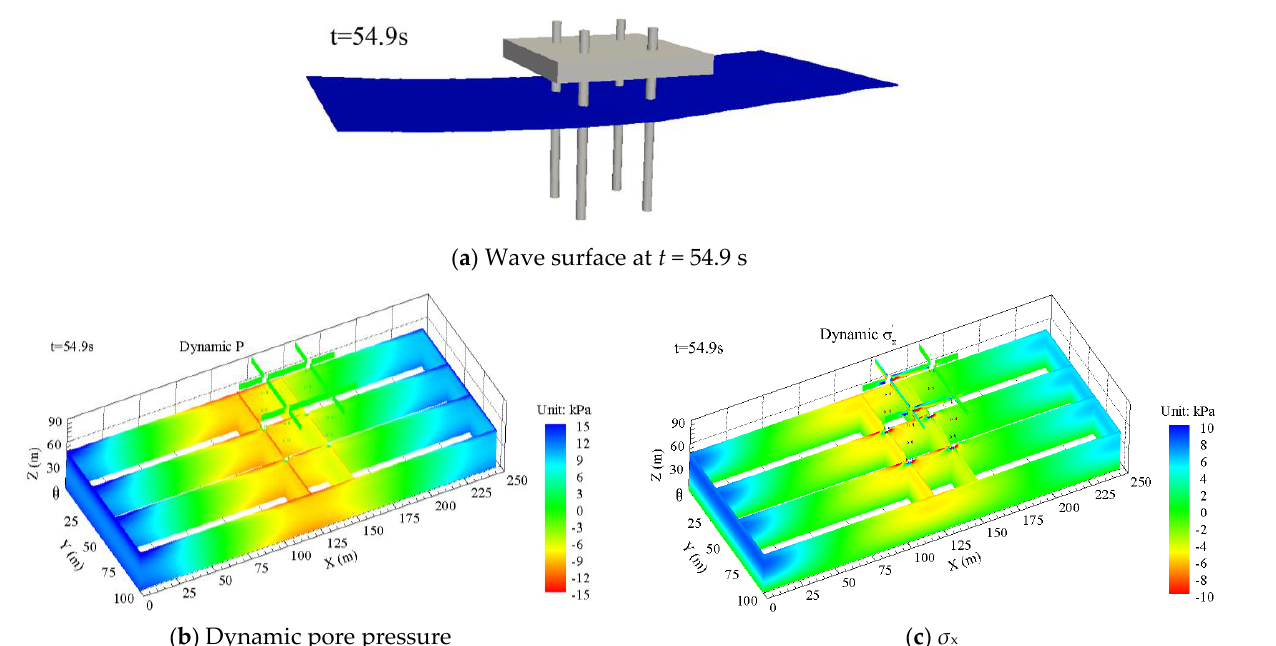
Figure 13. Time history of the horizontal displacement at the top of the jack-up platform under three conventional wave conditions.